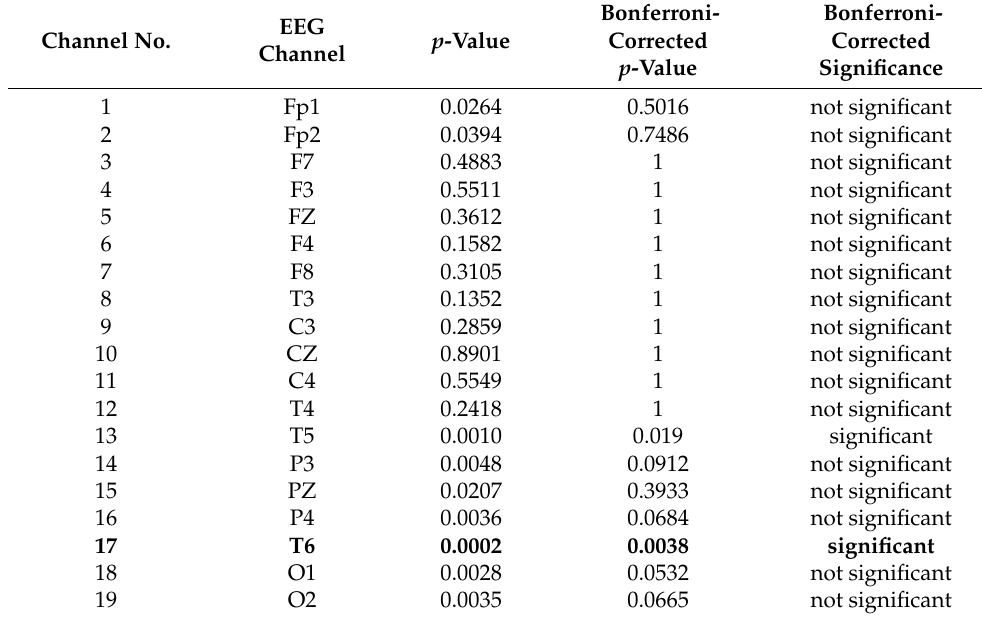
Table 2. p -value for theta/alpha ratio for TsEn